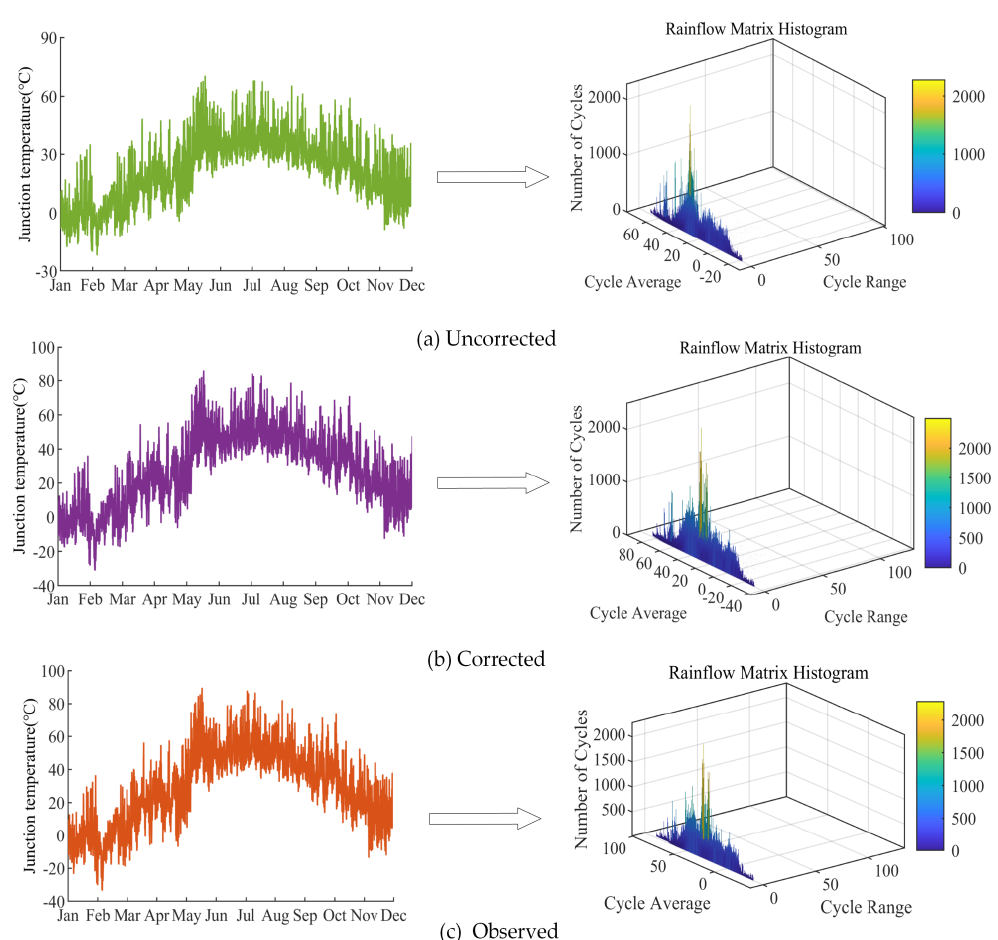
Figure11. ( a )Uncorrectedthermalstressloaddistribution. ( b )Correctedthermalstressloaddistribution. Figure 11. ( a ) Uncorrected thermal stress load distribution. ( b ) Corrected thermal stress load ( c ) Observed thermal stress load distribution. ( c ) Observed thermal stress load distribution.